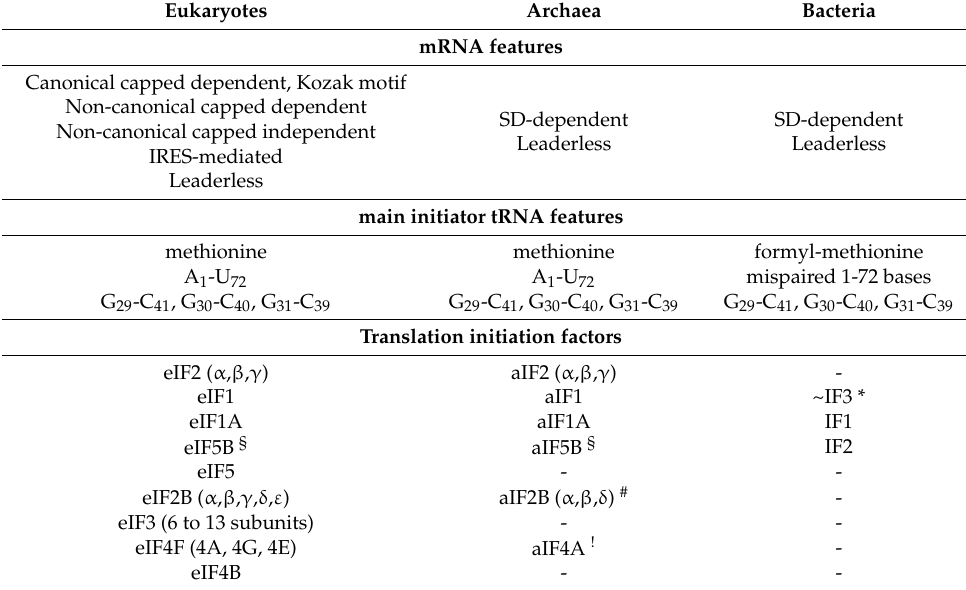
Figure 2. Definition of a common structural core for the start codon selection in eukaryotes and in archaea. The figure highlights the common elements used in eukaryotes and archaea for the key steps of the start codon selection. Left, eukaryotic PIC; middle, archaeal PIC; and right, common core. Table 1. The main features of the translation initiation in the three domains of life. The main mRNA, initiator tRNA features, and correspondence between the initiation factors in the three domains of life are shown. *: IF3 is a two-domain protein. The correspondence between IF3 and e/aIF1 is based on a structural and functional resemblance of the IF3 C-terminal domain with e/aIF1. Despite this resemblance, the topologies of the two α – β folds are different. This suggests a convergent evolution rather than the occurrence of a common ancestor. § : It should be underlined that, because of its homology with the bacterial IF2, aIF5B was misleadingly called aIF2 in some early publications. # : The catalytic γ and ε subunits of eIF2B are missing in archaea. The function of the eIF2B α , β , δ homologues in archaea is not clear [43,44]. ! : aIF4A present in some archaea.